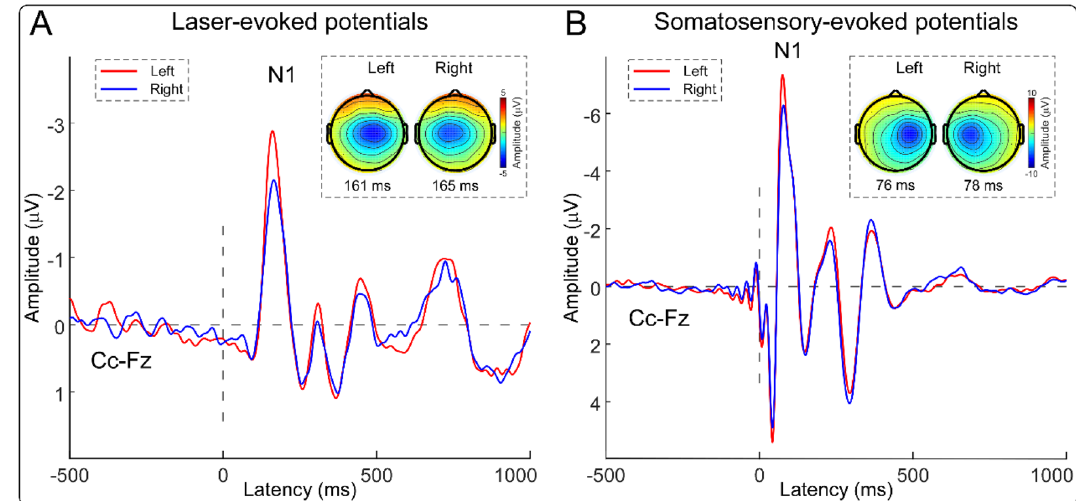
Figure 2. Group-level ERP waveforms and N1 scalp topographies elicited by nociceptive and non-nociceptive somatosensory stimuli. Group-level ERP waveforms (Cc-Fz) and N1 scalp topographies elicited by nociceptive somatosensory and non-nociceptive somatosensory stimuli that were delivered to the left (red lines) and right (blue lines) sides are respectively displayed in ( A,B ). The N1 amplitudes elicited by somatosensory stimuli delivered to the left side were significantly larger than to the right